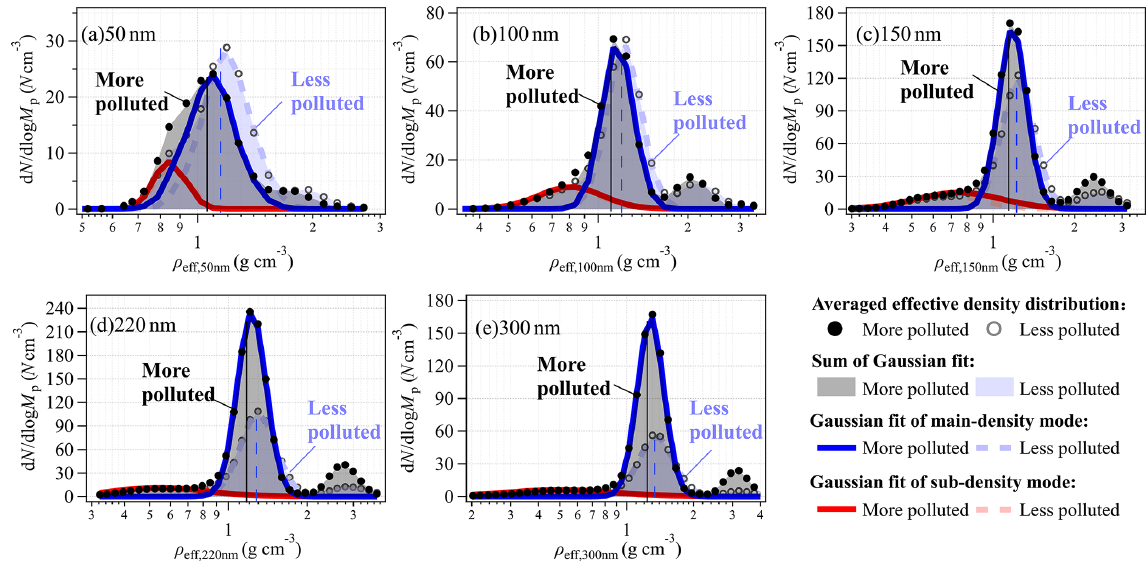
Figure 4. Averaged particle effective density ( ρ eff ) distribution for (a) 50nm, (b) 100nm, (c) 150nm, (d) 220nm, and (e) 300nm particles under the more polluted and less polluted conditions. Table 2. The geometric mean effective density ( ρ eff , sub and ρ eff , main ) of the sub-density and main density modes and the number fraction ( F sub ) and occurrence frequency of the sub-density mode under the more polluted and the less polluted